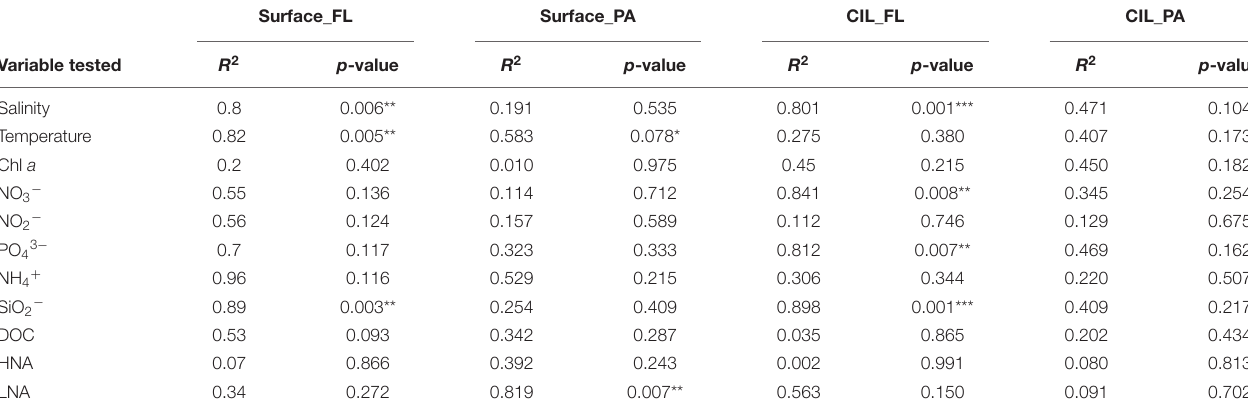
FIGURE 2 | Within-sample (alpha-) (A) and between-sample (beta-) (B) diversity of the bacterioplankton assemblages inhabiting the St. Lawrence Estuary. The surveyed bacterial communities are defined by depth (surface or cold intermediate layer: CIL) and lifestyle as determined by size-fractionation (free-living: FL indicated by orange or particle-attached: PA indicated by green). For alpha-diversity, the phylogenetic diversity, (realized) species richness, and evenness of PA and FL communities were compared at the surface and the CIL. The significance levels as determined in the corresponding Welch’s t -tests are shown in (A) : *** P < 0.01, ** P < 0.05, * P < 0.1. TABLE 1 | Principal coordinate analysis (PCoA) and permutation test analyzing the correlation between environmental variables and beta diversity. Surface_FL Surface_PA CIL_FL